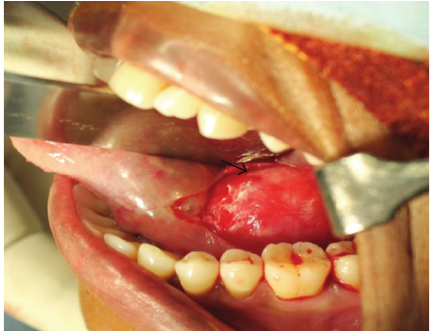
Figure 4: Intraoperative picture showing mucosal incision and exposed encapsulated mass (black arrow) in the left floor of the